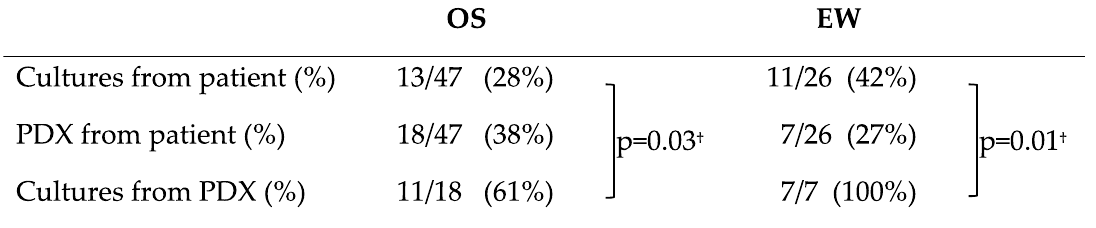
Table 2. PDX versus in vitro cell cultures. † χ 2 , 3 × 2 contingency